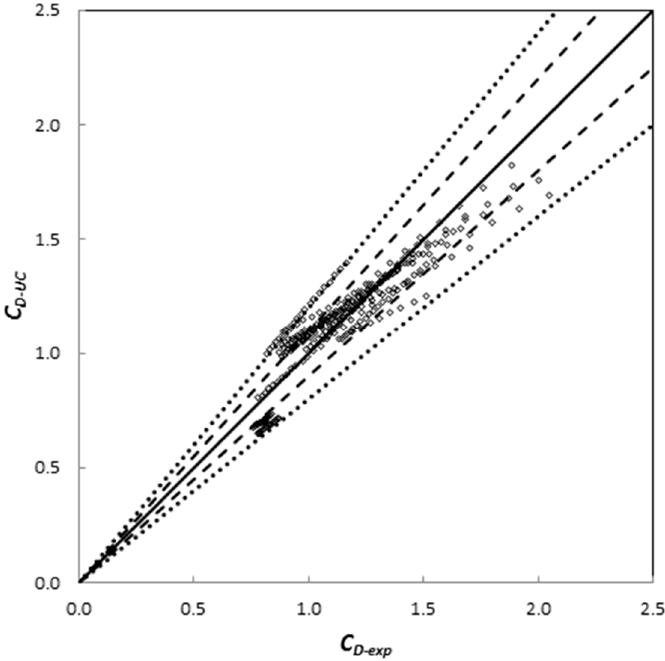
Figure 9. Comparison of the computed C D − UC values using Equation (28) vs. the experimental ones. The dashed lines indicate an error equal to ±10%; the dotted lines indicate an error equal to ±20%.